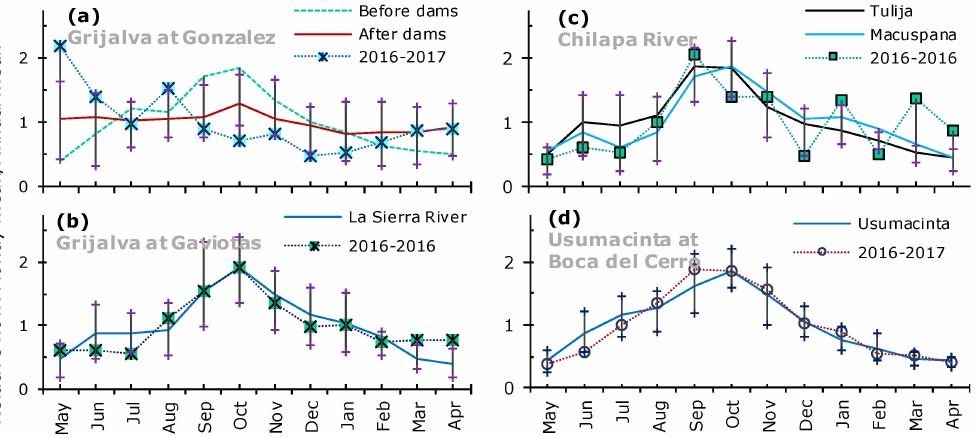
Figure 2. Relative flows in the lower Grijalva-Usumacinta system: ( a ) Grijalva main channel down- stream from dams (Carrizal at Gonzalez gauging station) (Before dams: data from 1958 to 1964; After dams: data from 1974 to 2022); ( b ) Main tributaries for the Chilapa: Tulija (Salto de Agua gauging station from 1953 to 2014) and Macuspana (Macuspana gauging station from 1955 to 2020); ( c ) La Sierra before joining with Carrizal (Gaviotas gauging station from 1962 to 2022); ( d ) Usumacinta upstream from San Pedro entrance at Tenosique (Boca del Cerro gauging station from 1949 to 2022). Solid lines: Inter-annual mean hydrographs; Markets purples (+): Boundaries placed at 35 percentile from the